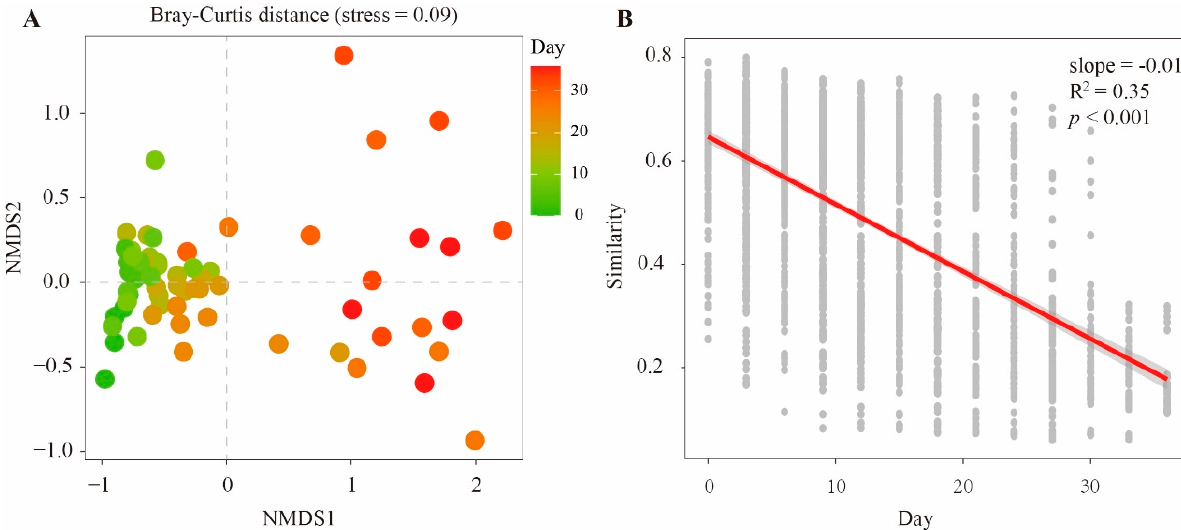
Figure 2. Bacterial communities changed with the PMI. ( A ) Nonmetric multidimensional scaling (NMDS) plots of bacterial communities based on the Bray ‒ Curtis distances. ( B ) Significant linear relationships between the similarities of bacterial communities and the number of days of decomposition were observed in gravesoil.